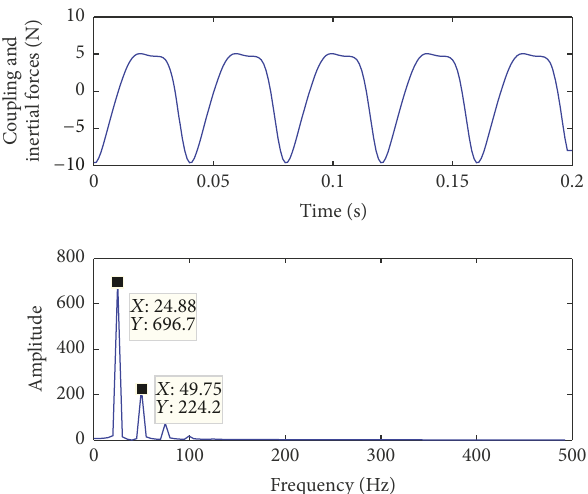
Figure 6: The response and amplitude-frequency characteristics of inertial force and coupling force.